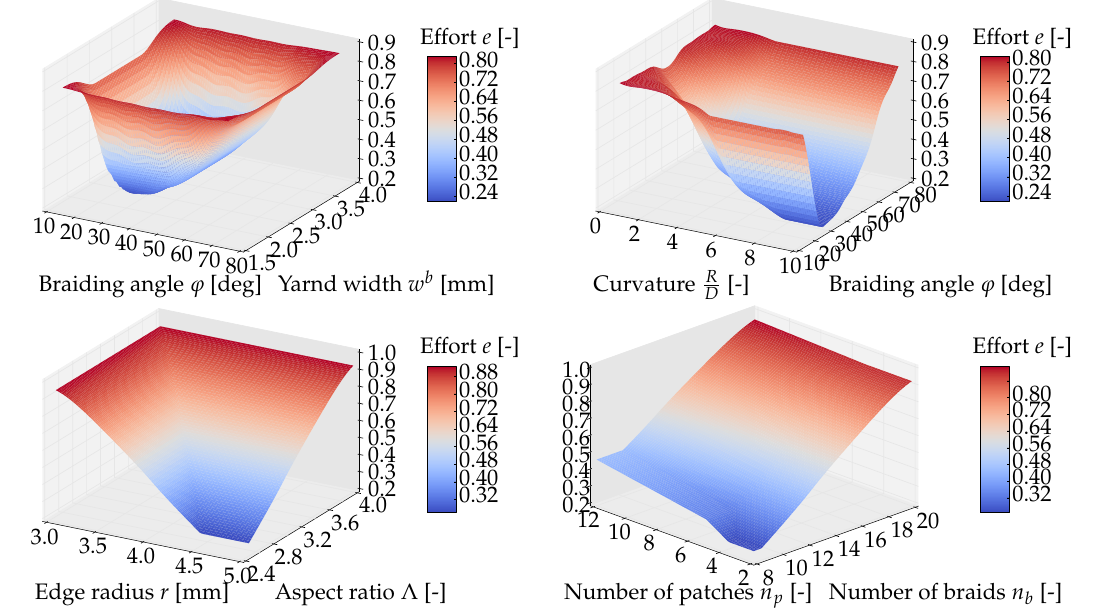
Figure A2. Response surfaces of the manufacturing effort model over different process variables.